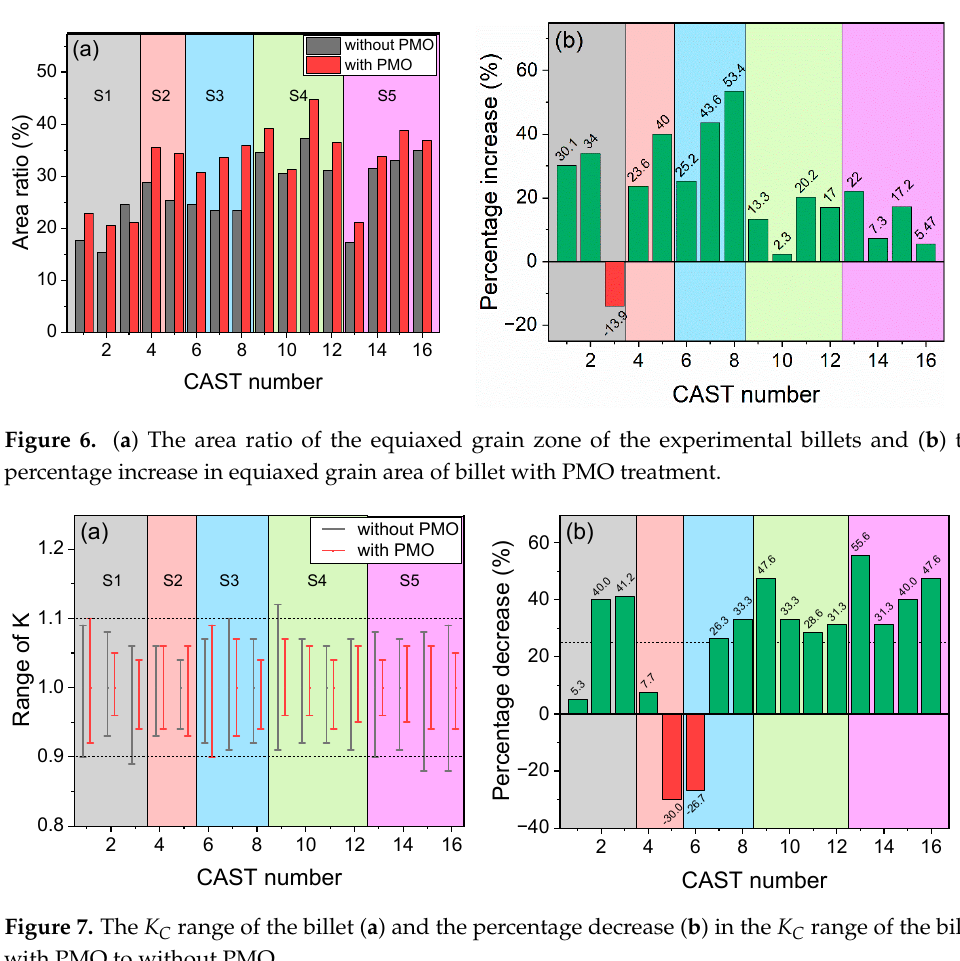
Figure 5. Macrosegregation in radial direction of No.11 billet sample.